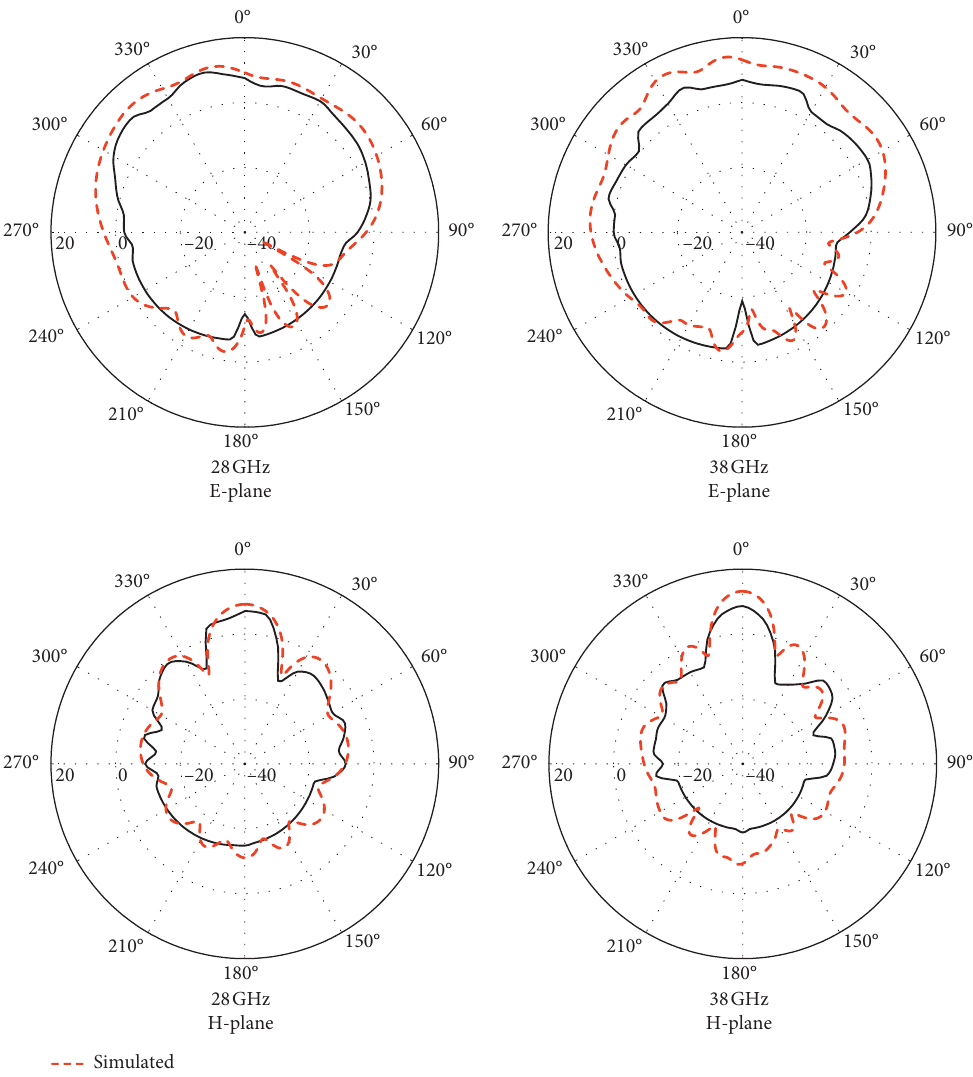
Figure 13: Simulated and measured radiation patterns of the proposed antenna array (unit: